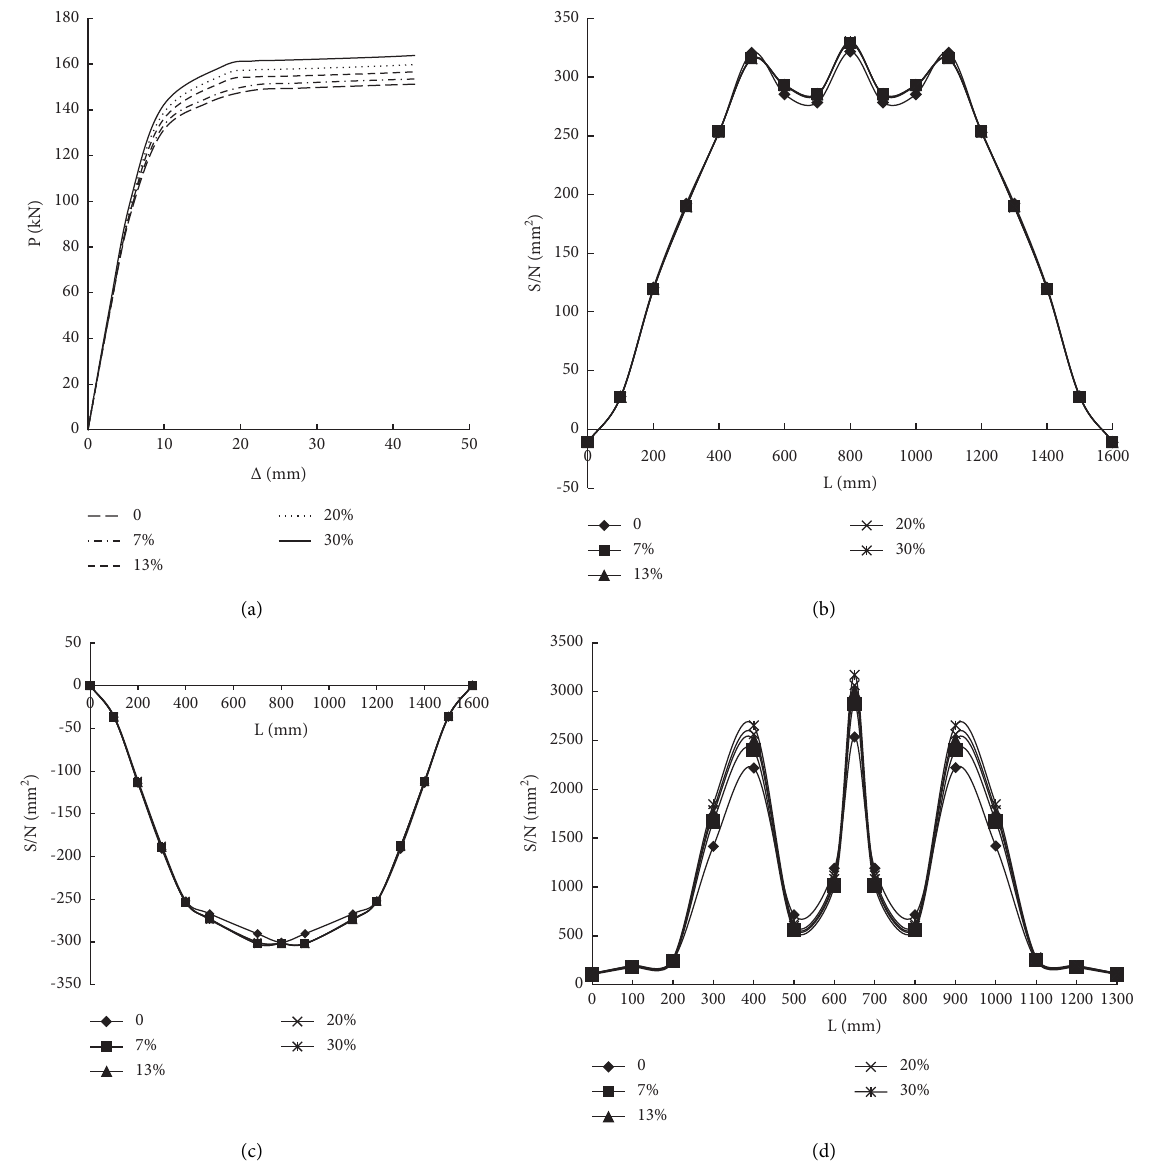
Figure 20: Effect of prestressing degree. (a) Load and deflection. (b) Stress along steel beam length. (c) Stress along steel beam width. (d) Stress along CFRP sheet’s